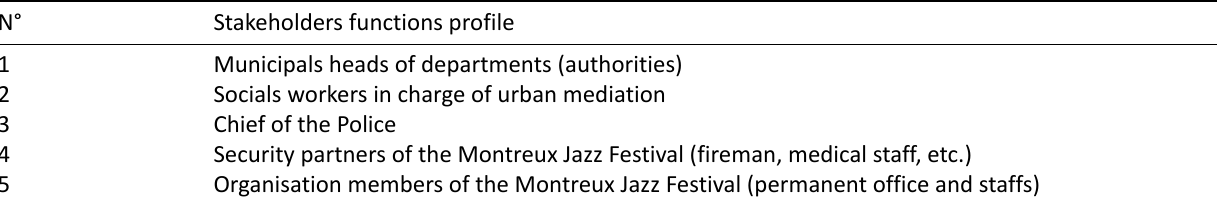
Table 1. Semi-structured interviews’ profiles.